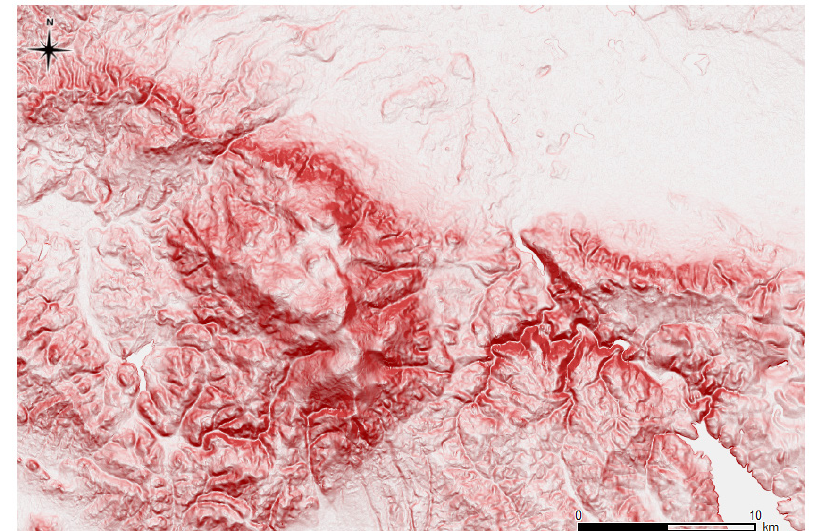
Fig. 6. Red relief visualization with red slope and two-directional